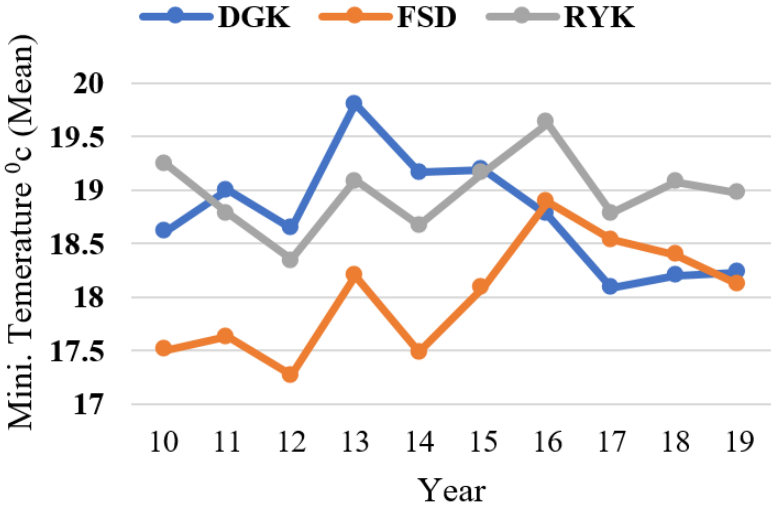
Figure 5. Minimum temperature (mean) of study locations (2010–2019).